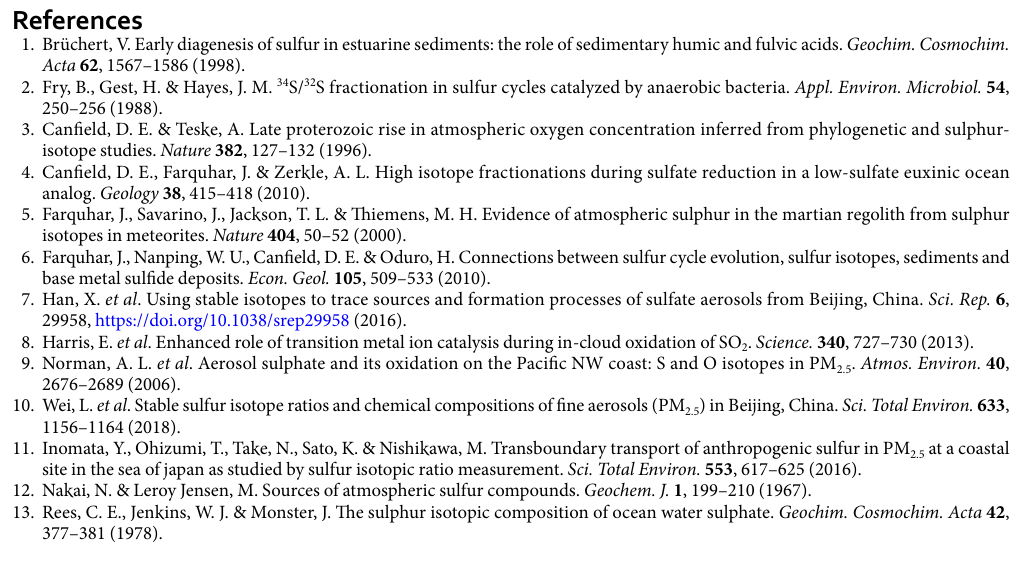
measured at LLN strongly suggests LLN can be a representative site for regional background sulfate. The regional contribution from coal industry, however, is yet to be determined and that is critically dependent on the source characteristics of sulfur-bearing compounds from oil industry which has not been quantified in east Asia.